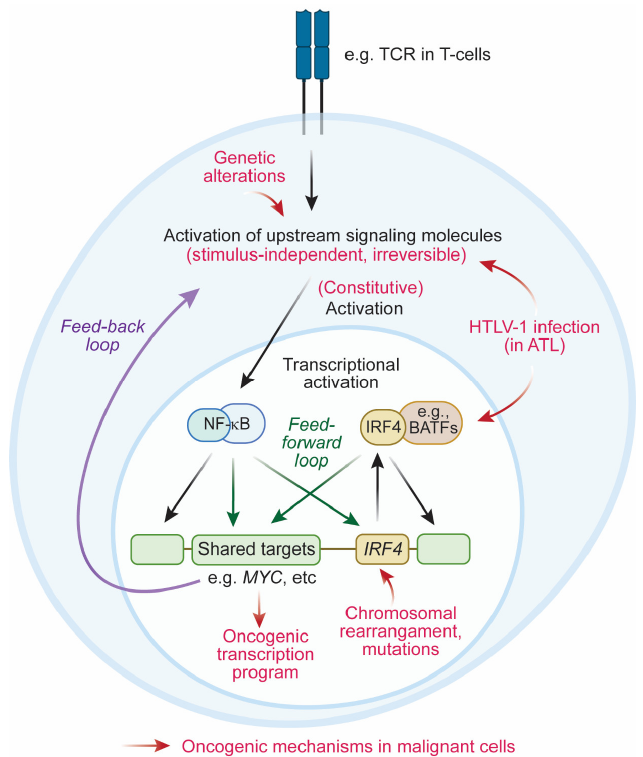
Figure 1. Signaling pathway and molecular mechanisms that activate IRF4 in malignant cells. In normal T cells, MHC–TCR interaction activates upstream intracellular signaling pathways, which leads to the activation of NF-κB. Similarly, in normal B cells, receptor signaling (e.g., BCR) leads to the activation of NF-κB. NF-κB in turn transcriptionally upregulates IRF4 , which induces critical immune cell responses. This mechanism is thought to be stimulus-dependent and, thus, reversible. In contrast, in malignant lymphocytes (e.g., DLBCL, ALCL, and ATL), the NF-κB–IRF4 pathway is often constitutively activated in a stimulus-independent manner due to several oncogenic mechanisms (red arrows). Genetic alterations in the upstream signaling pathway can constitutively activate NF-κB. HTLV-1 infection, which is observed specifically in ATL cells, can also activate NF-κB and induce the expression of interacting partner of IRF4 (i.e., BATFs). IRF4 gene expression can also be aberrantly induced via chromosomal rearrangements (e.g., chromosomal translocation and amplification). IRF4 protein function may also be altered due to genetic mutations. These mechanisms lead to the constitutive activation of NF-κB and/or IRF4, which induces the oncogenic transcription program. Furthermore, NF-κB and IRF4 activate the upstream signaling pathways via a feedback loop and also regulate the same targets (e.g., MYC ) via a coherent feedforward loop, which further enhances the transcription program.